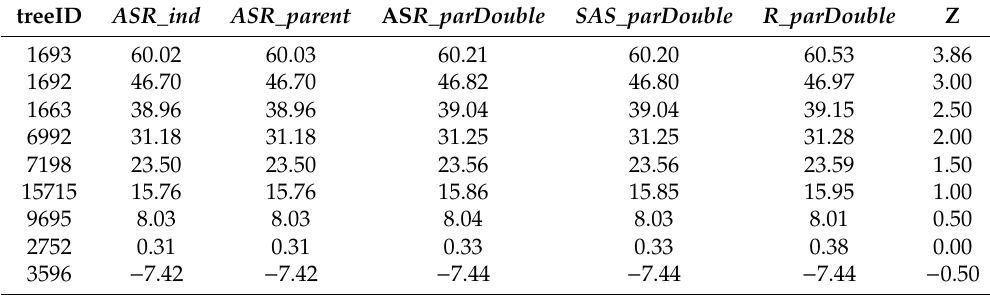
1 The analyses varied according to the software (ASREML, SAS Proc Mixed, or R lme4), linear model terms (individual tree or parent model), and / or the use of a normal or modified doubled dataset. 2 Standard error of prediction for each of the 80 SCA e ff ects was estimated directly by the software. 3 z-values based on BV predictions from model ASR_ind . Finally, as with the parental breeding value predictions, for the progeny breeding value predictions ( â ), the five di ff erent linear models produced nearly identical predictions for particular genotypes (Table 6). For any progeny with a z-score more than 0.50, the predictions from the di ff erent linear models di ff ered only at the third significant figure. For example, for Tree 1692, with a z-score = + 3.00 for the predicted BV, the predictions from the five linear models were â = 46.70, 46.70, 46.82, 46.97, and 46.80. Since there were 6000 progeny, the z-score of the predicted breeding values covered a wider range (z = − 2.80 to + 3.86) than was observed among the 40 parents (z = − 2.30 to + 2.30). Table 6. Individual tree-breeding value predictions from five linear mixed models 1 for a simulated full-sib progeny dataset with 40 parents, 80 families from an unbalanced mating design, 4 tests, and 25 trees / family / test. SD( â ) = the observed standard deviation of the population of 6000 breeding value predictions. SE(a − â ) = the average standard error of prediction 2 . Selected trees have breeding values that span the distribution of 6000 trees; standardized z-values are listed 3